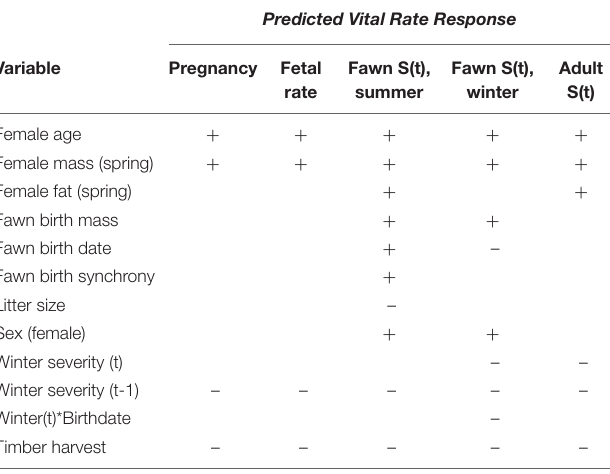
TABLE 1 | Hypothesized effects of covariates on vital rates for Sitka black-tailed deer, Prince of Wales Island, AK, United States